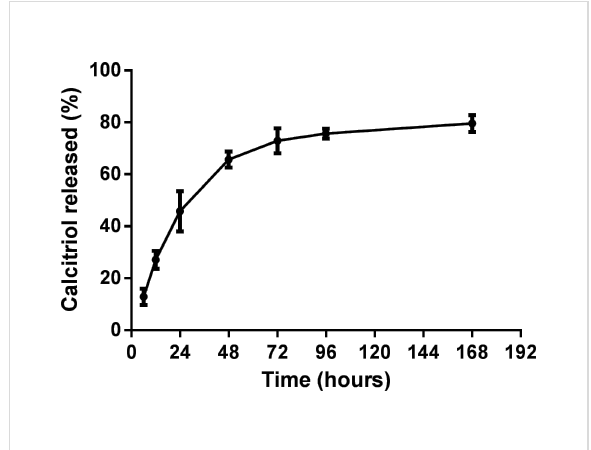
Figure 2: In vitro release profile of calcitriol from PLGA NPs in PBS (0.01 M, pH 7.4) at 37 °C. The data is represented as the mean ± SD ( n =